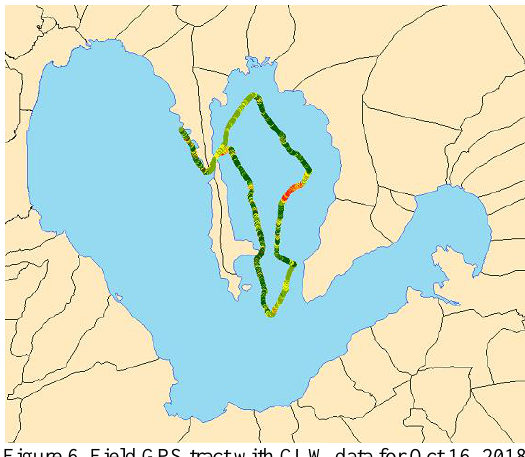
Figure 6. Field GPS tract with CLW data for Oct 16, 2018